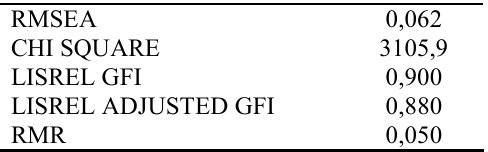
Table 4: Measures of fit of the empirical model RMSEA